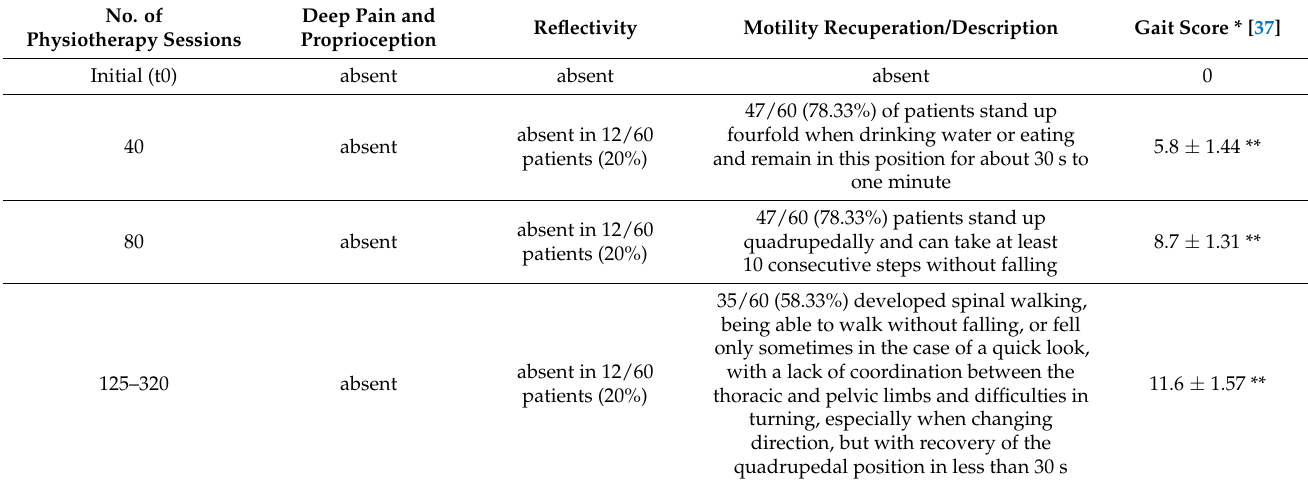
Table 3. Degree of recuperation of reflectivity and motility after physiotherapy (60